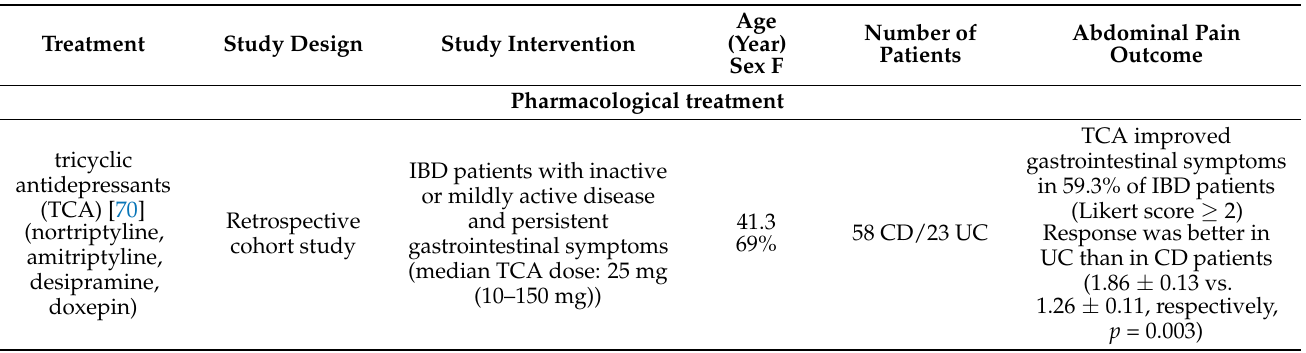
Table 1. Data supporting the efficacy of pharmacological and non-pharmacological interventions in IBD patients with chronic abdominal